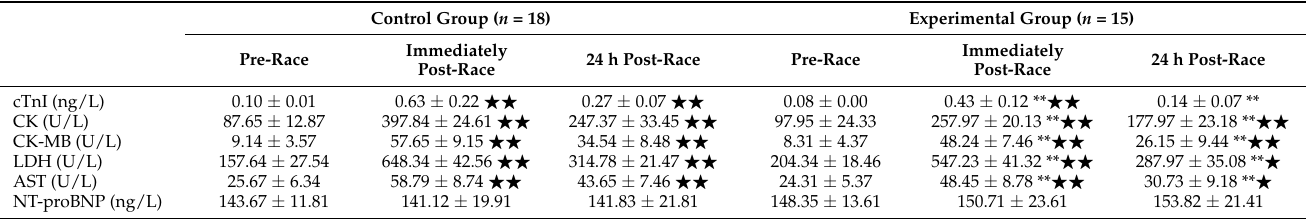
Table 4. Changes in the levels of markers of myocardial injury before, immediately after, and 24 h after the marathon